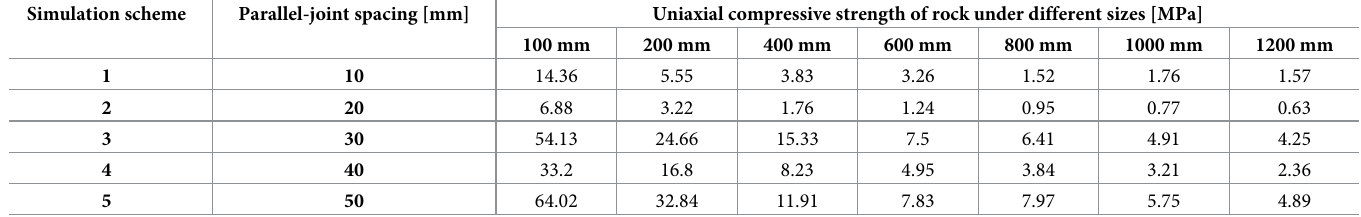
Table 4. Summary of uniaxial compressive strength under all working